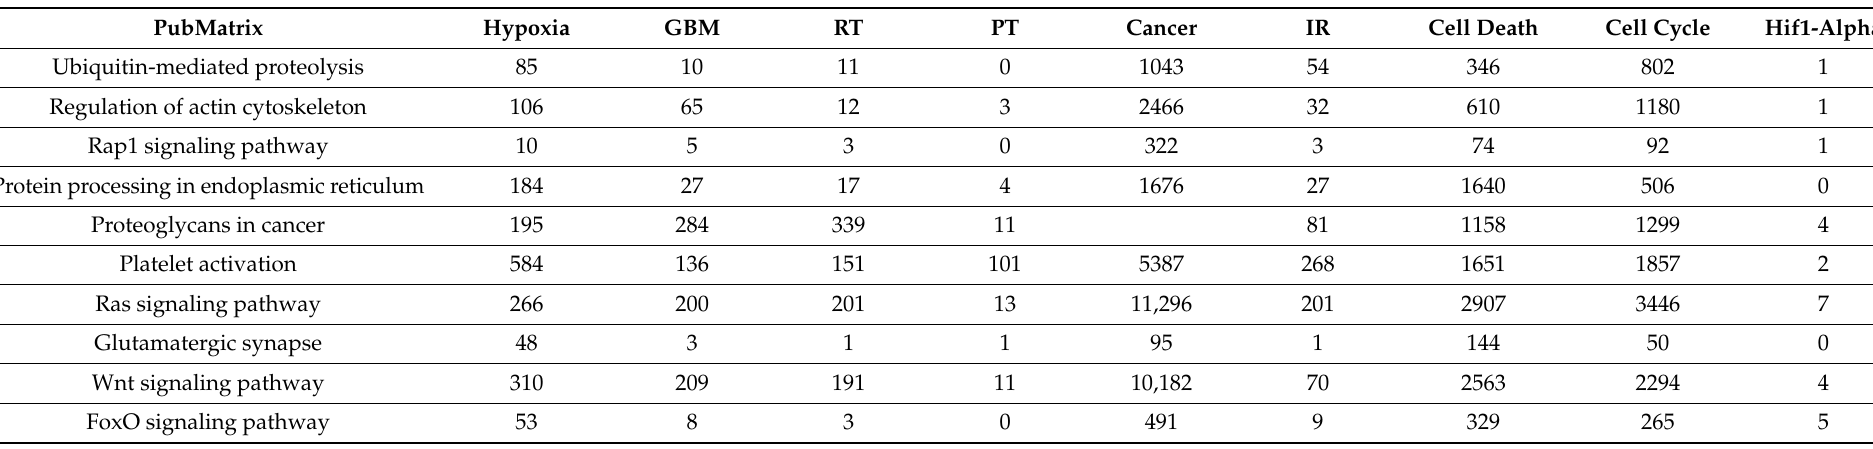
Table 5. Pubmatrix analysis of the top 10 statistically relevant pathways ( p values < 0.05) obtained from the 2898-gene signature, upregulated by the combined treatment hypoxia/PT with